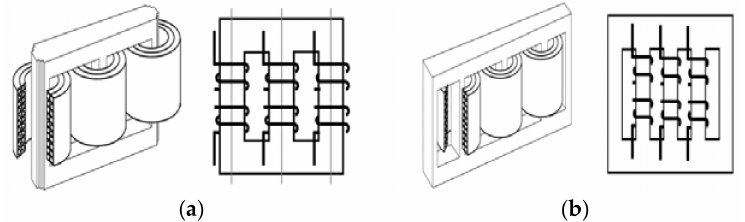
Figure 2. ( a ) Three-limb core-type transformer. ( b ) Five-limb core-type